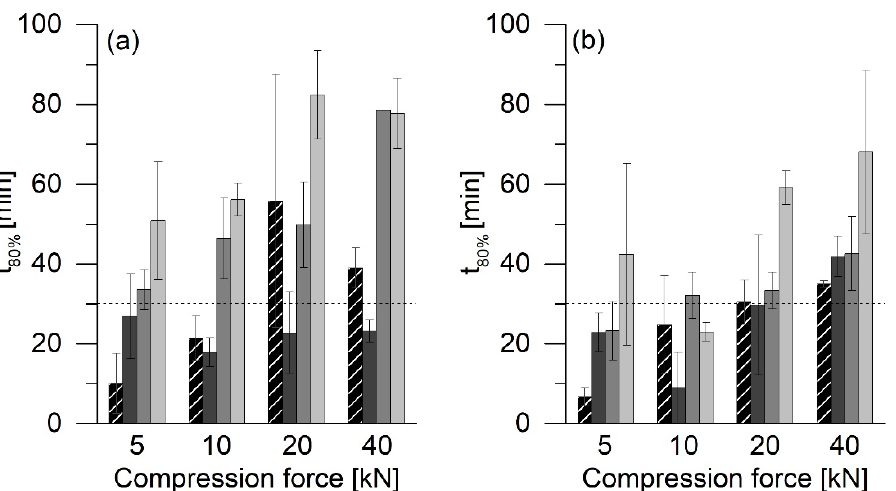
Figure 9. T 80% values of tablets with MCC 200 compressed at a dwell time of 1 s. Black-striped bars: ASD directly after preparation; dark gray bars: PM directly after preparation; gray bars: ASD after six months of storage at 23 °C/75% RH; light gray bars: ASD after six months of storage at 40 °C/75% RH. ( a ) ASD/PM VA30 tablets, ( b ) ASD/PM VA40 tablets, average ± SD, n = 2.